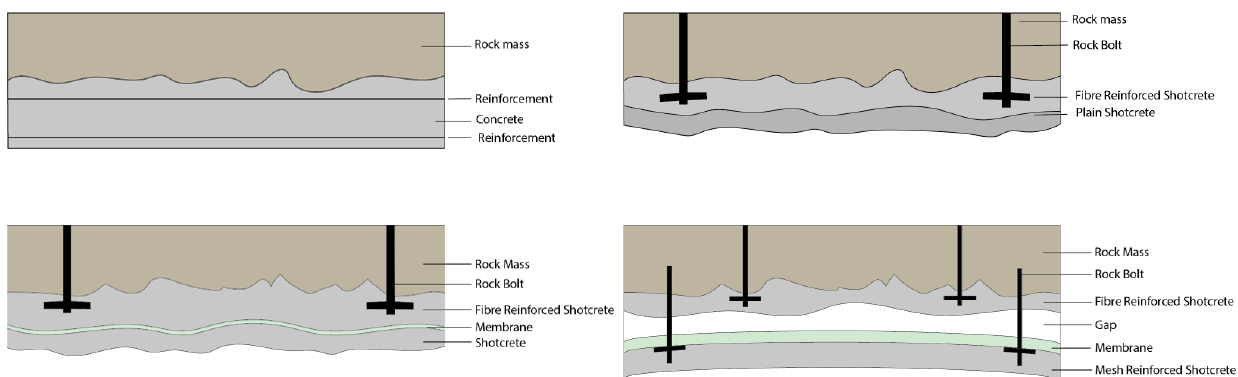
Figure 2. Different types of commonly used concrete rock support. From top to bottom, left to right, reinforced concrete, shotcrete on hard rock with rock bolts, sandwich shotcrete lining with a waterproof membrane, and shotcrete with a second waterproof lining, from Sjölander